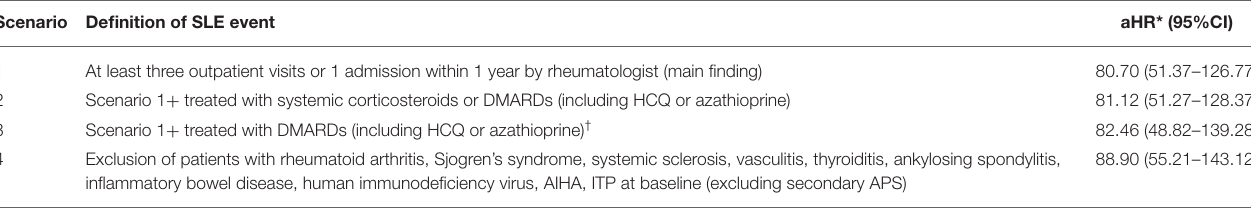
TABLE 3 | Sensitivity analysis in the estimation of the SLE risk for APS exposure in age-matched and sex-matched